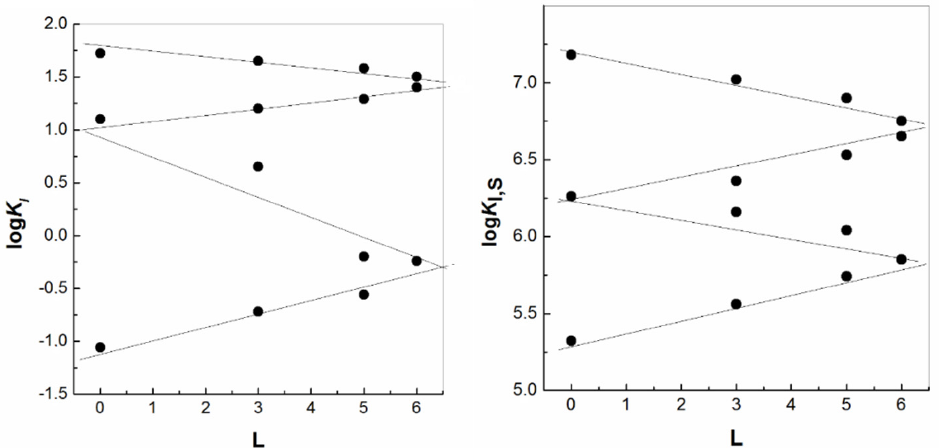
Figure 15. Variation of log K I ( K I,S ) values with total angular momentum, L , of the rare earth ions. The straight lines are drawn for visual impacts only.